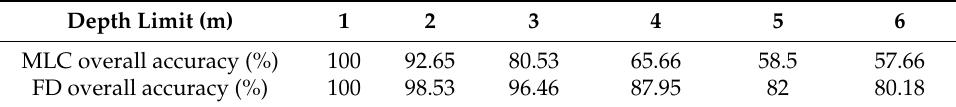
Figure 8. Comparison of FD and MLC kelp detection results. ( a ) Spatial distribution of the classified kelp and ( b ) kelp area detected per depth. Table 5. Depth dependent kelp/Non-kelp detection